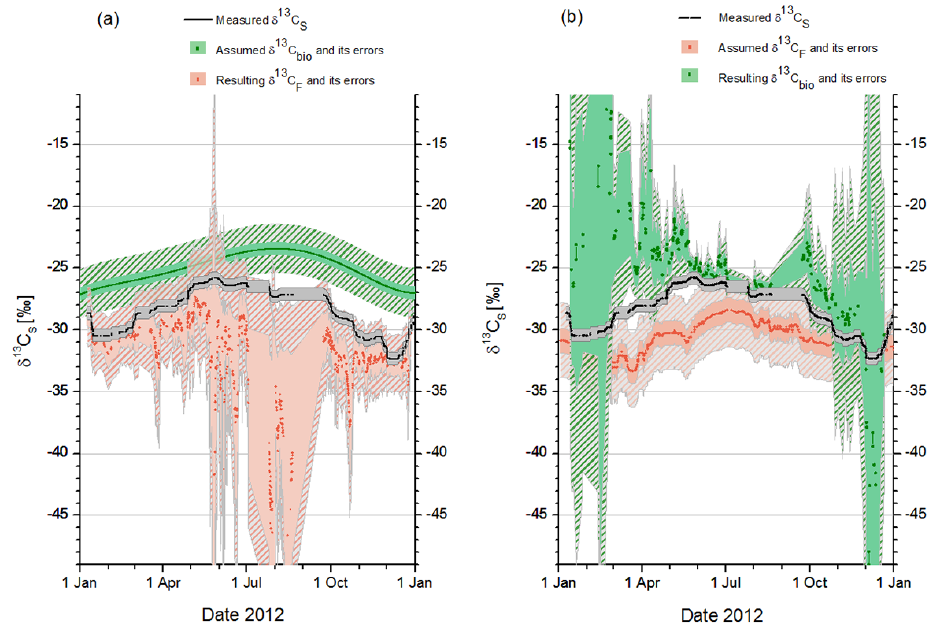
Figure 5. (a) A fixed isotopic end member of the biosphere (green, ± uncertainty of 0.5‰ (light green area) and 2‰ (crosshatched green)) together with the measured source signature (black) results in δ F (red, ± its uncertainty). (b) A fixed isotopic end member of the fuel mix (red, ± uncertainty of 1.0‰ (salmon pink) and 2.0‰ (crosshatched gray-pink)) together with the measured source signature (black) results in δ (green, ± its uncertainty). In both cases, also the fuel CO 2 share (or biospheric CO 2 share) is required. We here use the share calculated with STILT on the basis of EDGAR v4.3 and assume an absolute uncertainty of